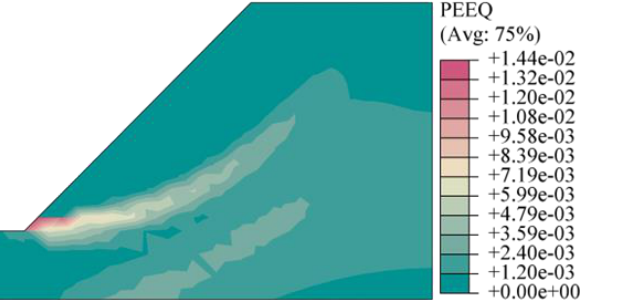
Figure 6. Equivalent plastic strain cloud calculated by the double strength reduction method.